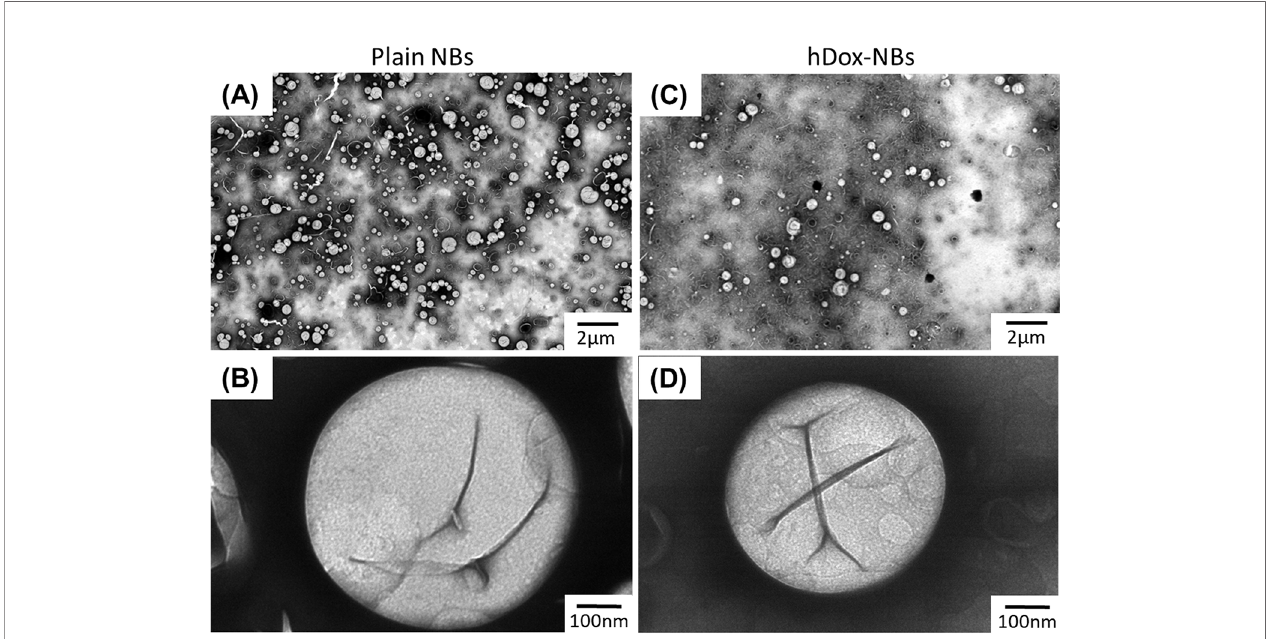
FIGURE 2 | Representative transmission electron microscope (TEM) images showing size and morphology of plain nanobubbles (NBs) or unloaded-NBs (A , B) and hDox-NBs (C , D) carried out using uranyl acetate staining. TEM studies were repeated in triplicate. The hDox-NBs show distinct patchy domains and increased ridges and buckles compared to bubbles without